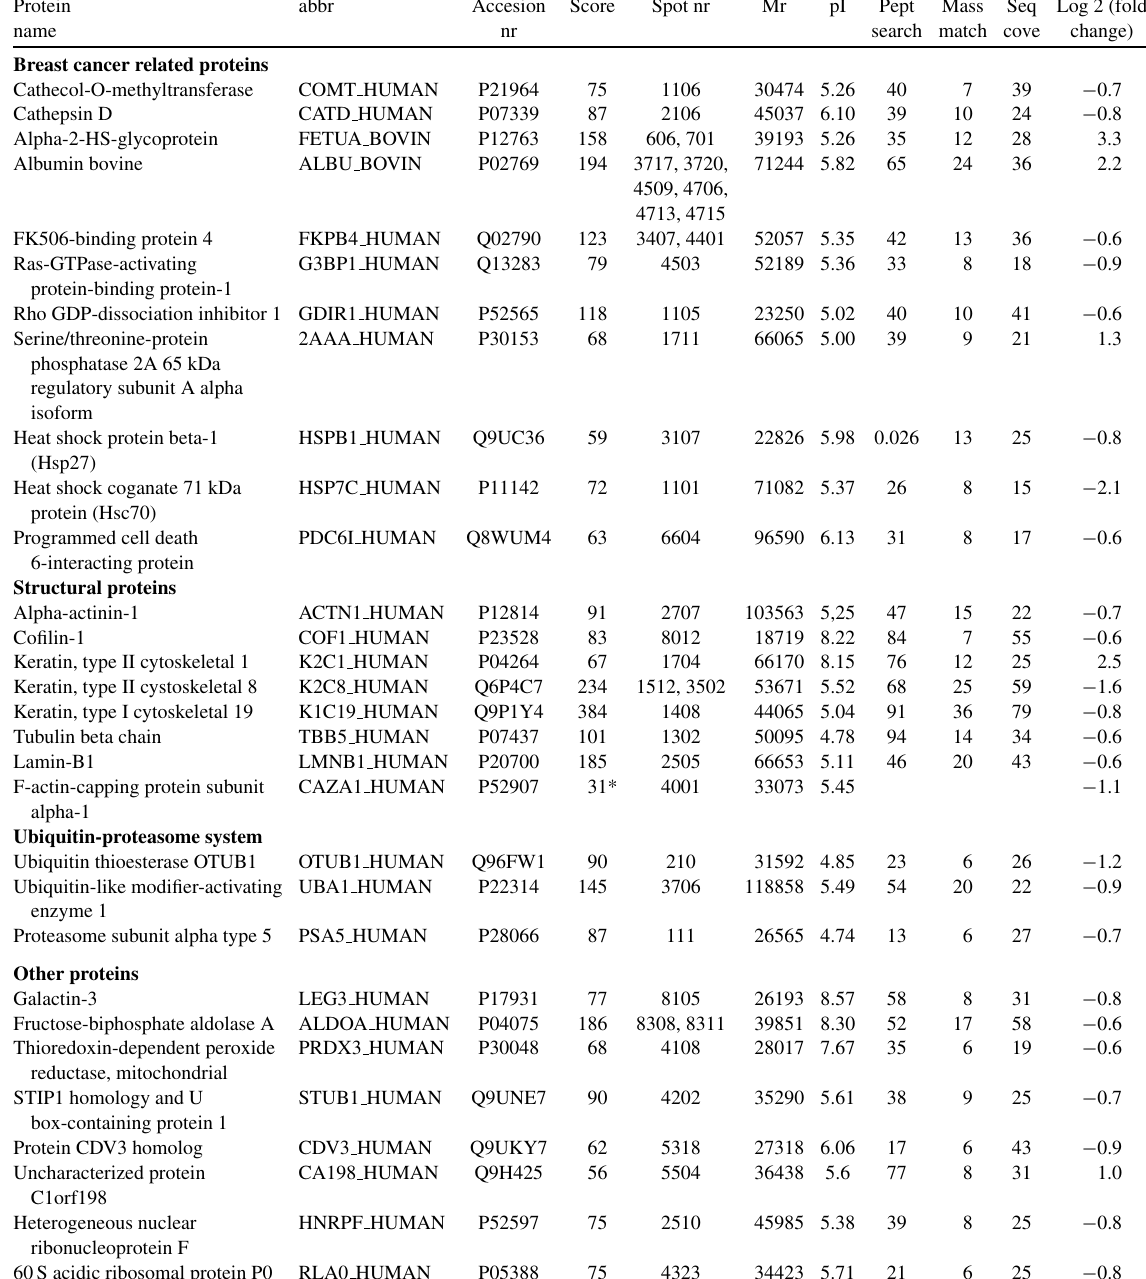
Identification of leptin-modulated proteins by MALDI-TOF MS in MCF-7 breast cancer cells